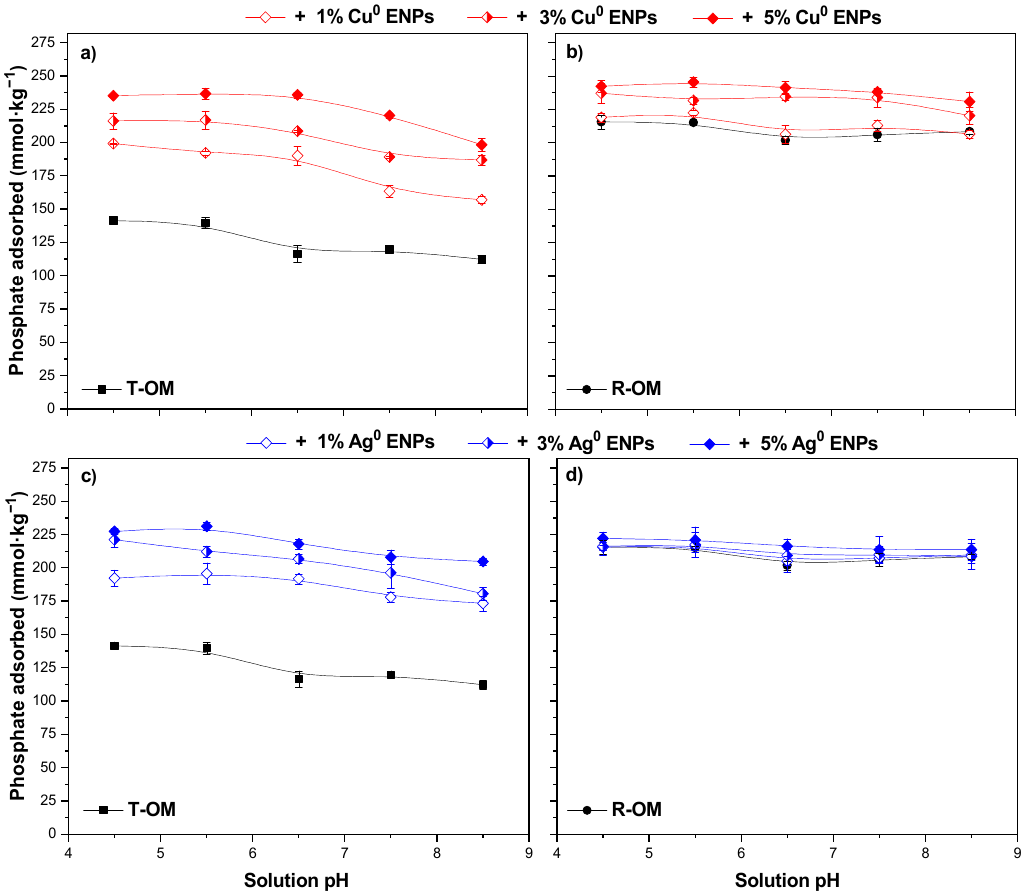
Figure 2. Initial pH effect of the solution on the adsorption of H 2 PO 4 − in the presence of Cu 0 ENPs on soil with ( a ) total organic matter (T-OM) and ( b ) partial removal of organic matter (R-OM) and Ag 0 ENPs on soil with ( c ) T-OM and ( d ) R-OM.